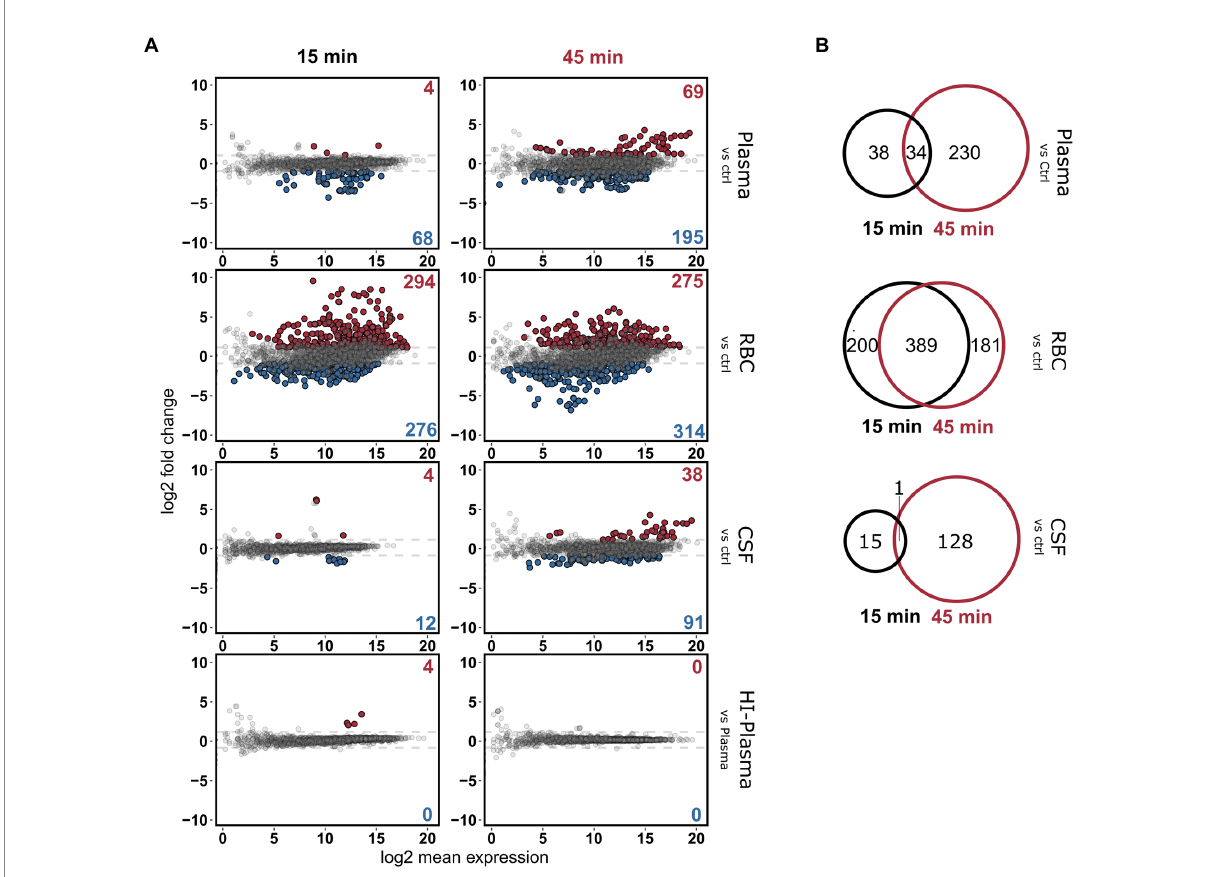
FIGURE 2 (A) MA-plots depicting the differentially expressed pneumococcal genes in 20% plasma, RBC and CSF cultures compared to the control CDM culture, at the two time points, 15 and 45 min. Differentially expressed genes in HI-plasma were also compared plasma. Red and blue dots represent significantly up-and downregulated genes, respectively [log 2 (FC) > 1 and FDR < 0.01]. (B) Veen-diagrams show the overlap in differentially expressed genes between the two time